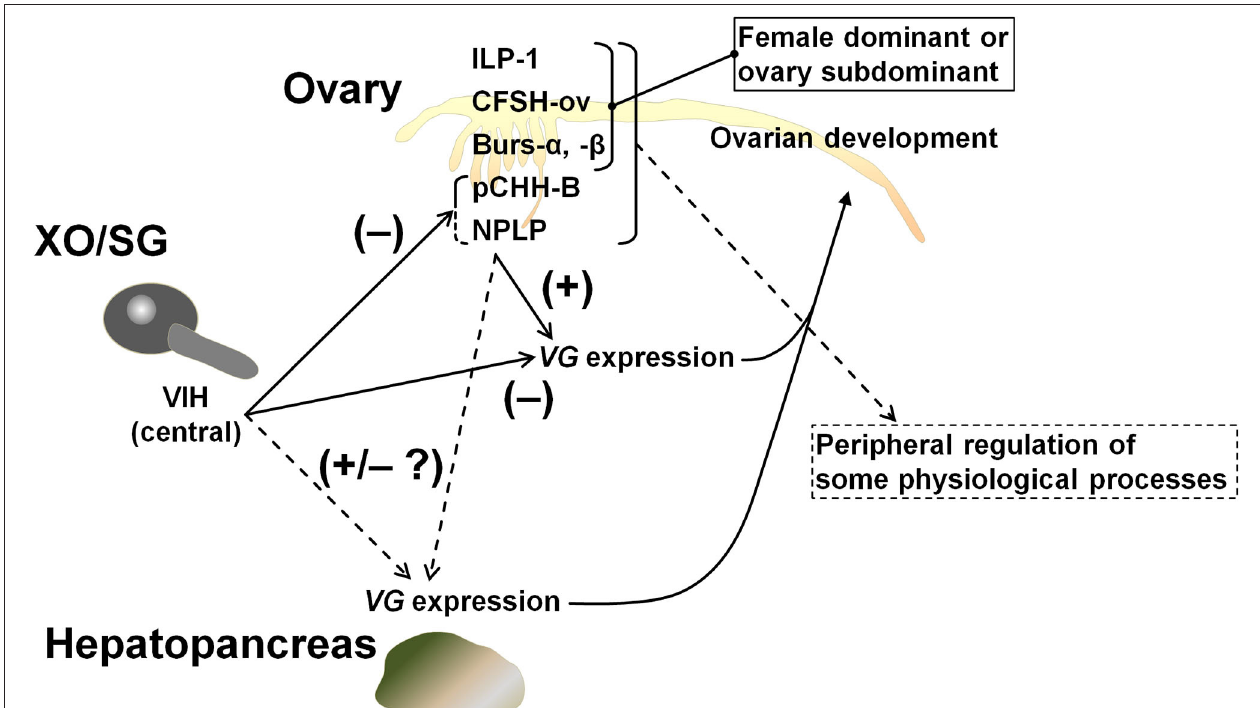
FIGURE 7 | Schematic model of peripheral regulation of the ovary. It is highly likely that Maj-NPLP is a vitellogenesis-regulating factor in M. japonicus considering its activity and the existence of a putative receptor in the ovary. The other female dominant or ovary subdominant hormones may play a role in some physiological processes. Maj-CFSH-ov has been previously characterized (